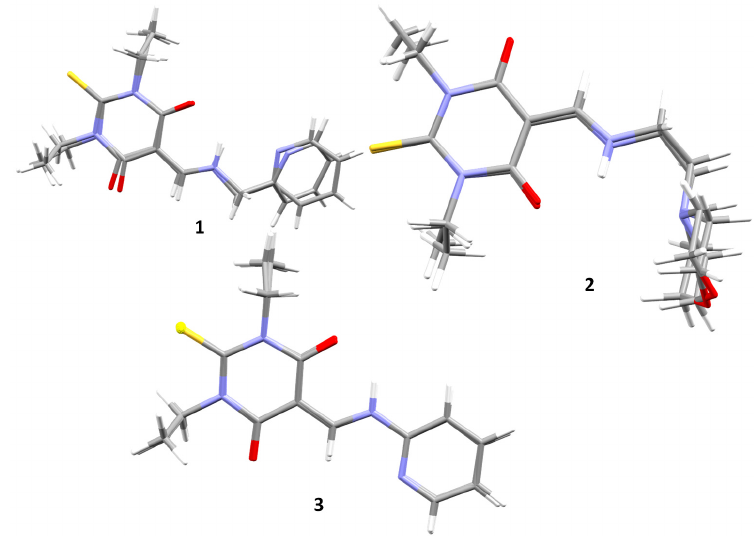
Figure 9. Overlay of crystal structures and optimized geometry of 1 – 3 .